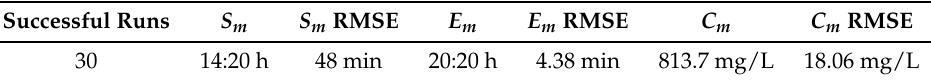
Table 1. Contamination event RMSE analysis for Net3 network of all 30 runs.